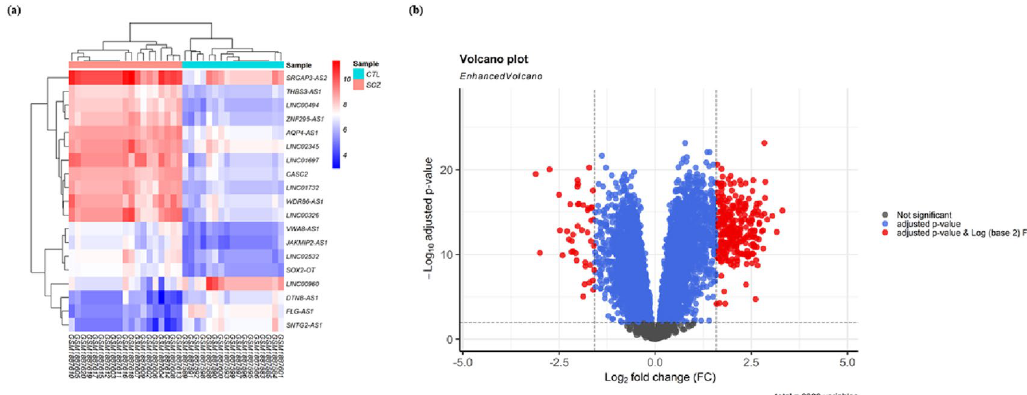
Figure 2. Differentially expressed lncRNAs (DElncRNAs) and mRNAs (DEmRNAs) between schizophrenia (SCZ) samples and control (CTL) samples. ( a ) Hierarchical clustering heatmap of DElncRNAs. High expressed lncRNAs are shown in red, while those expressed at low levels are blue. ( b ) Volcano plot for the DEmRNAs. The DElncRNAs and DEmRNAs were screened according to a |(log2FC)|> 1.585 and an adjusted P value < 0.001. This figure was made using Pheatmap and Enhanced Volcano packages of R version 4.0.3 (https:// www.r- proje ct. org/).